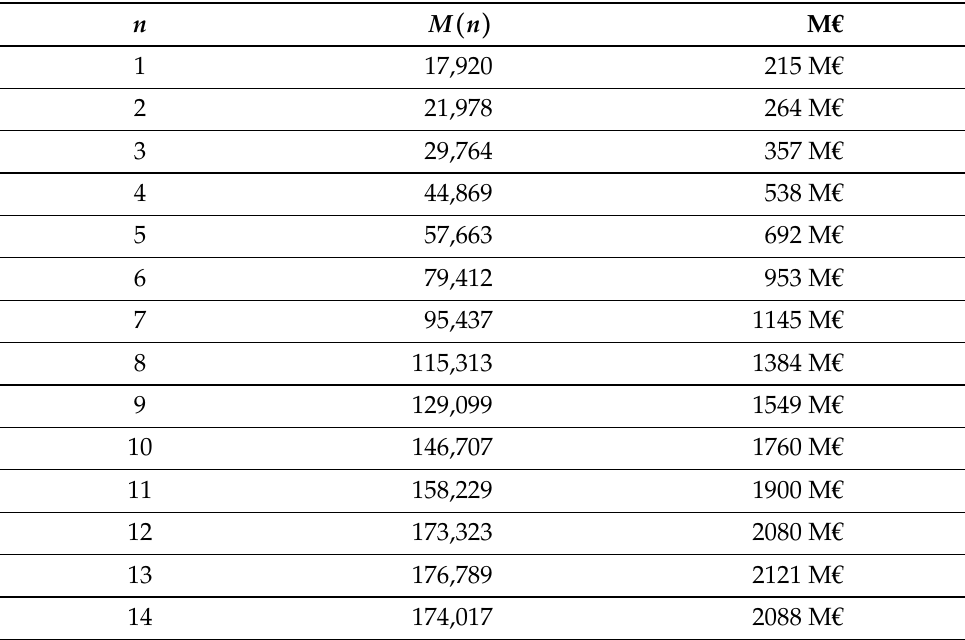
Table 5. Semester approximate economic cost for the care of the UAM